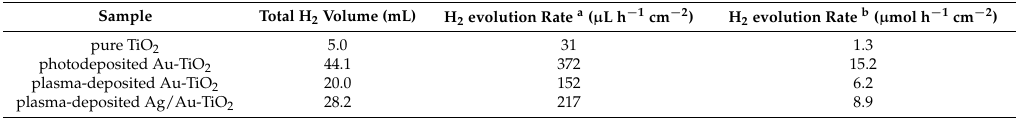
Table 2. Comparison of the produced amount of hydrogen and the respective photocatalytic activities normalized to the evolution of hydrogen per area and time.